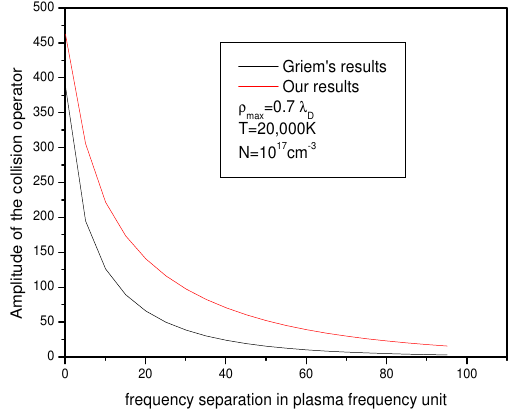
Figure 4. Amplitude of collision operator versus frequency separation in plasma frequency unit ¯ ω αα (cid:48) for Ne = 10 17 cm − 3 and a temperature 20,000 K. The amplitude is in π 2 A /768 unit where A is defined in the text as Equation (26) and ρ max = 0.7 λ D